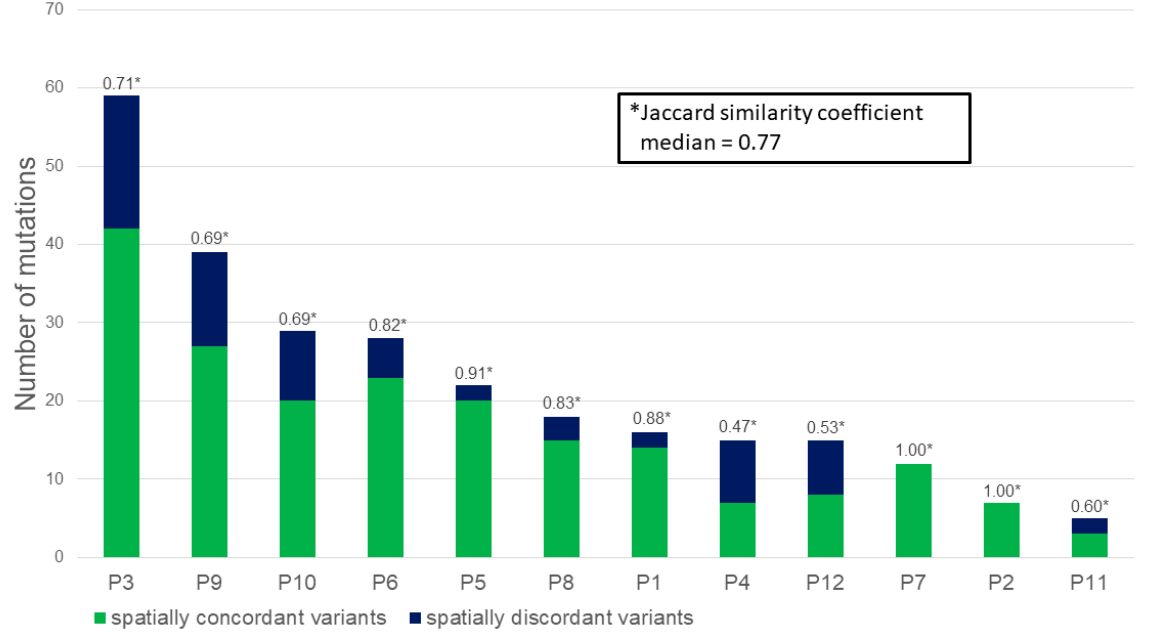
Figure 1. The number of non-synonymous, exonic mutations per patient with an allelic frequency of at least 10% in one of the samples. Concordant mutations that were found in all the biopsies are shown in green and discordant mutations that were not detected in at least one of the samples are shown in blue. The Jaccard similarity coefficient, indicating the similarity within the samples is given above the bar for each patient. The closer the coefficient is to one, the more homogeneous the lymphoma mass was.